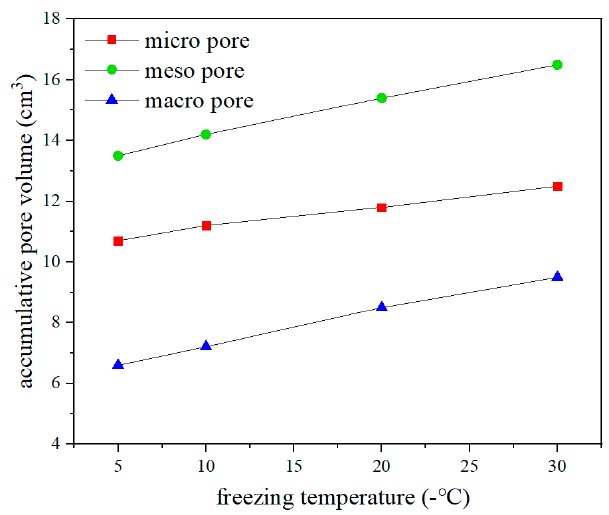
Figure 7. The curves of proportion with different pore sizes of thawed soils under different freezing temperatures.